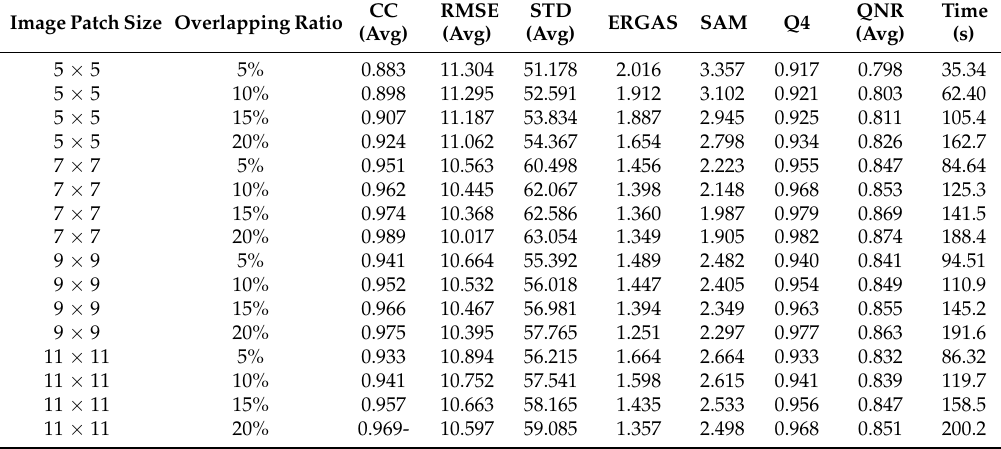
Table 8. Impact of image patch size and overlapping ratio on Triplesat image. Image Patch Size Overlapping